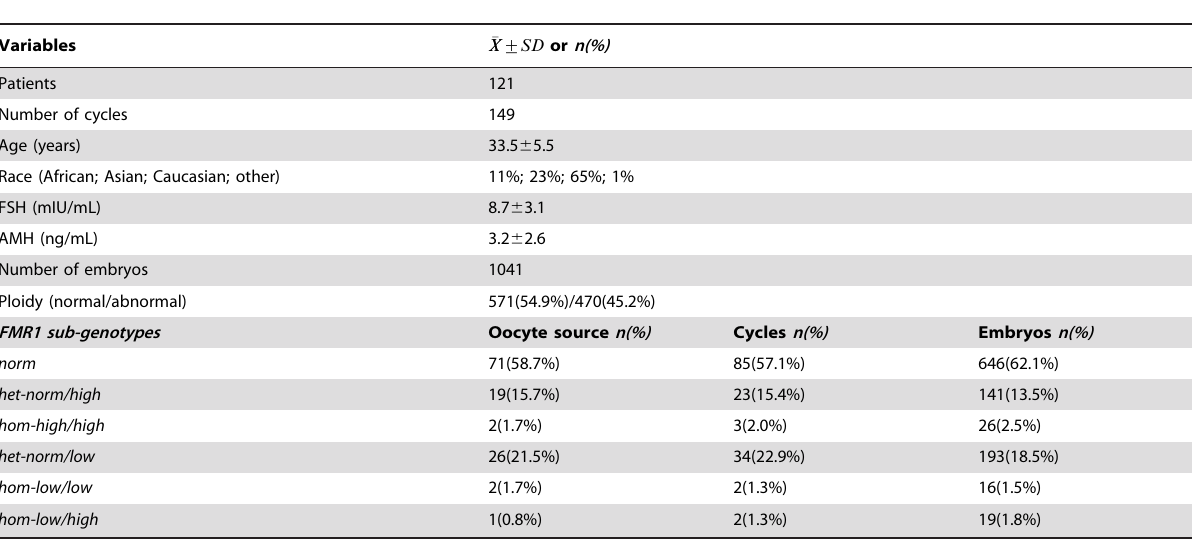
Table 2. Characteristics in section (ii) of women undergoing IVF for non-fertility related